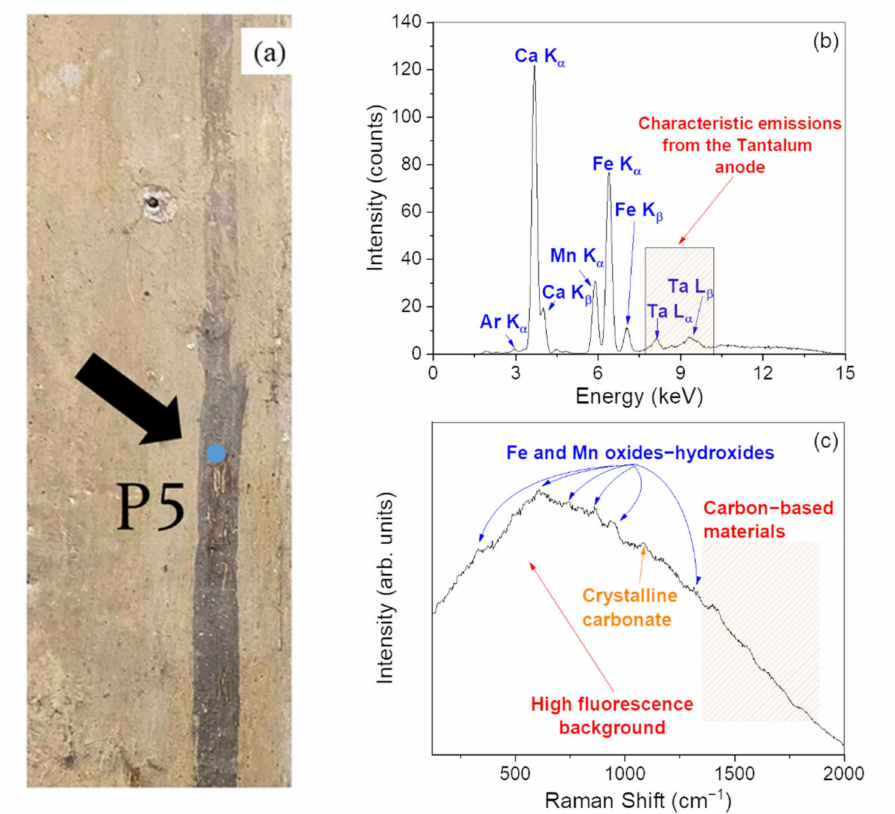
Figure 5. Photo of the point P5 (dark brown) ( a ). XRF spectrum recorded on the point P5 ( b ). Raman spectrum recorded on the point P5 ( c